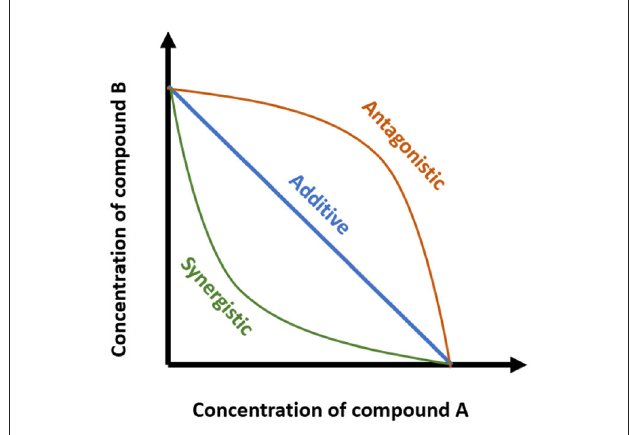
FIGURE2 Isobole method showing different types of combination effects (synergistic, antagonistic, and additive). Axes represent the concentration of the individual compounds, and the points represent the combination of concentrations of the two compounds required to reach a particular fixed